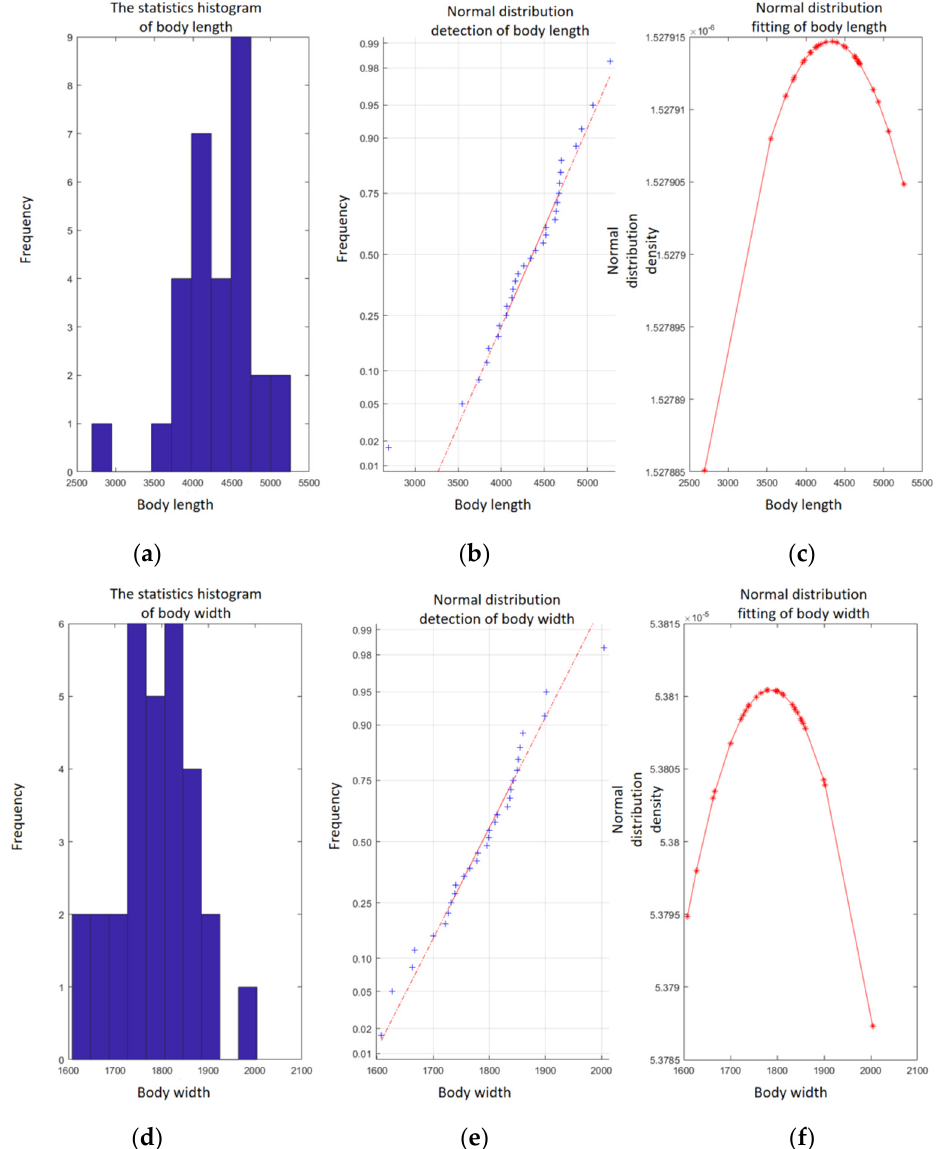
Figure 10. Normal distribution fitting of body size of the best-selling cars in the European Market. Note: The statistics histogram of body length/width of the best-selling cars ( a , d ); normal distribution detection of body length/width of the best-selling cars ( b , e ); normal distribution fitting of body length/width of the best-selling cars ( c , f ).